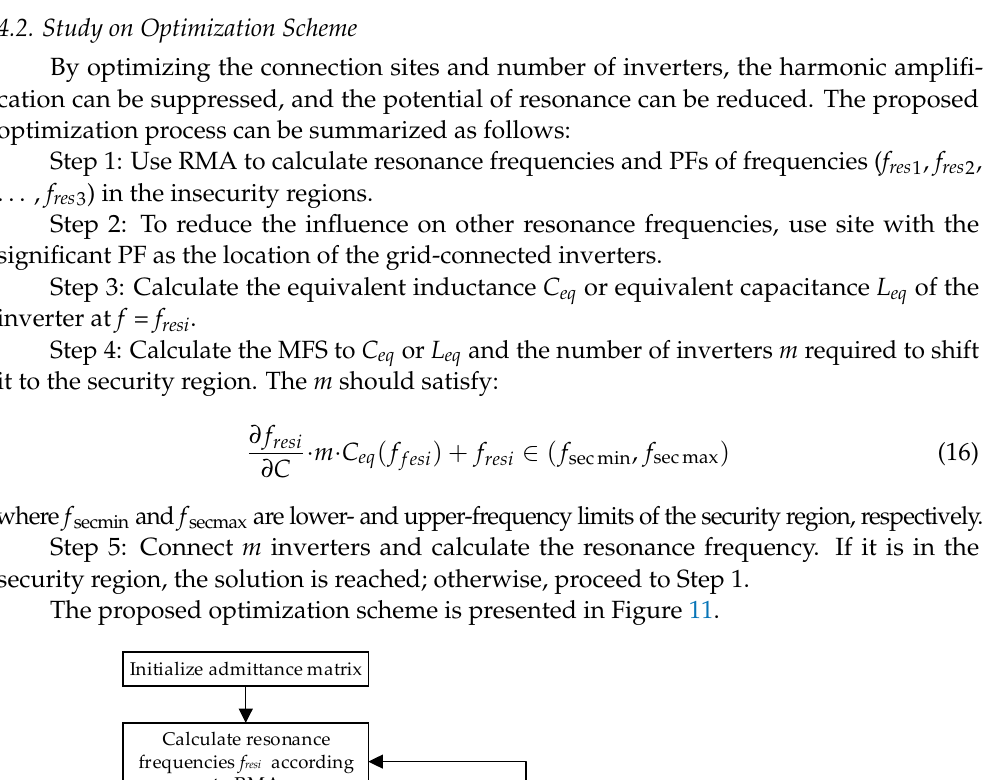
Figure 10. Diagram of the driving point impedance.